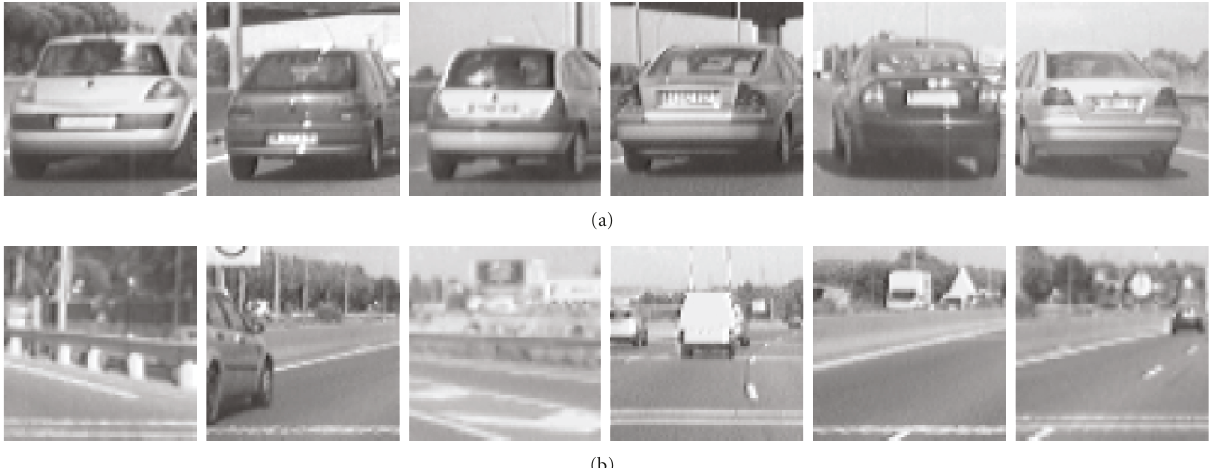
Figure 12: Forward data set. (a) positive samples (vehicles). (b) negative samples.